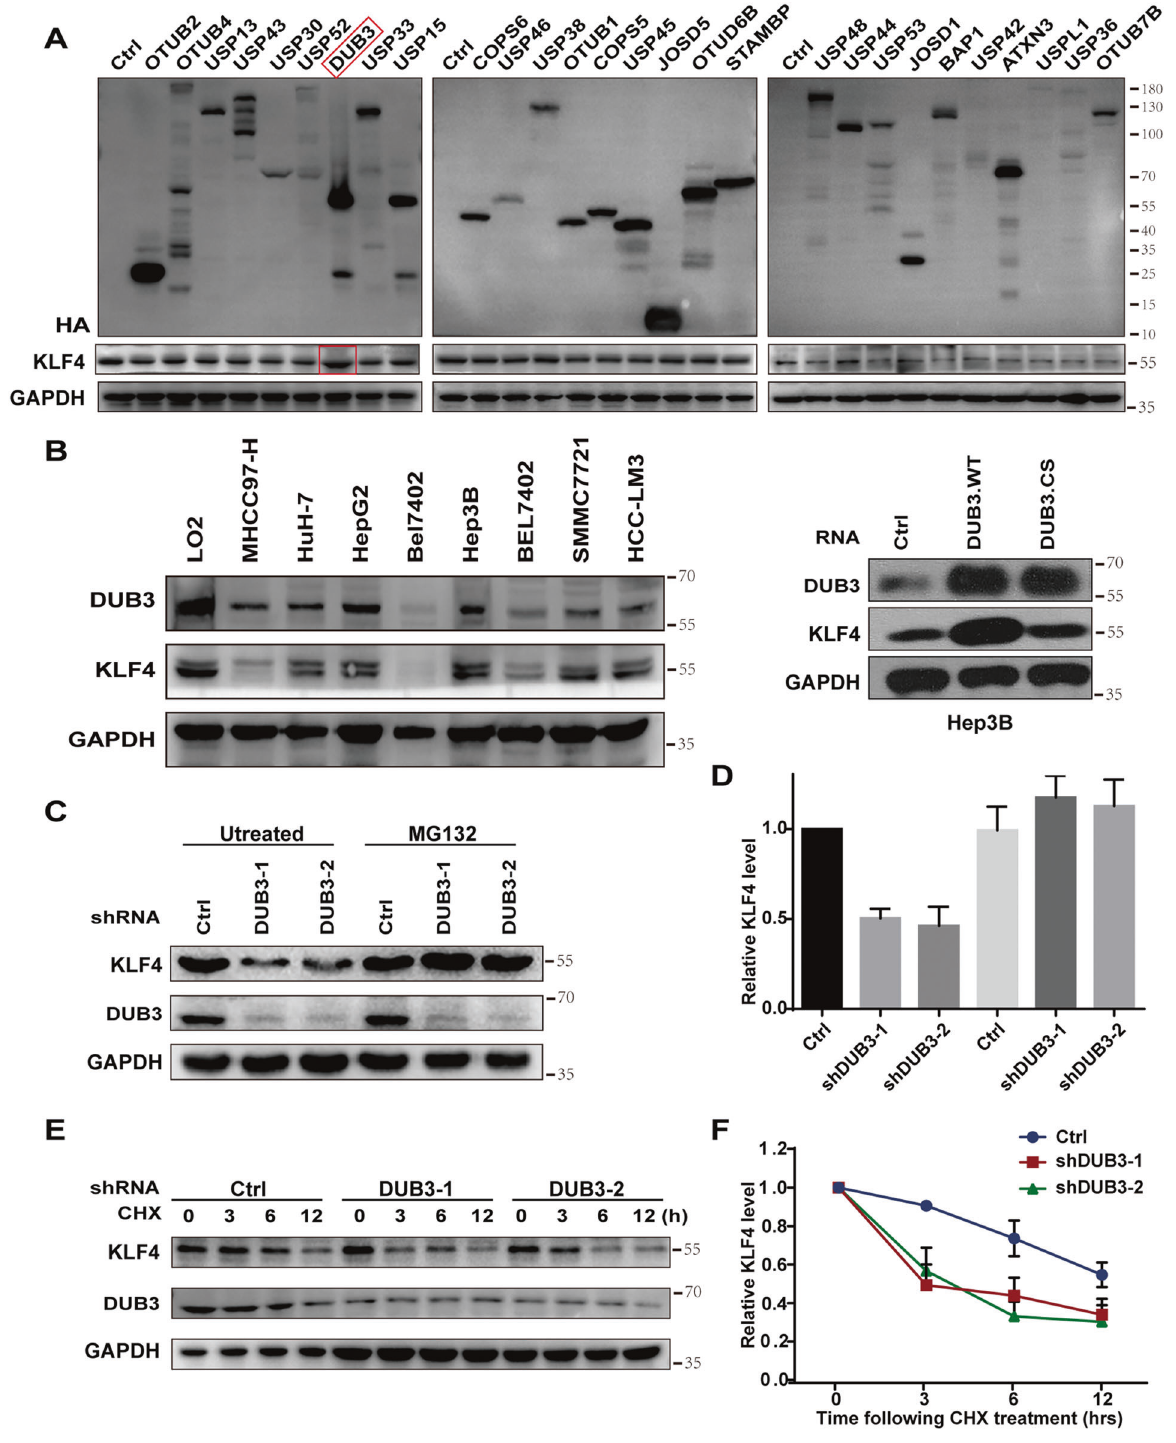
Fig. 1 Deubiquitinating enzyme 4 (DUB3) upregulated Krüppel-like factor 4 (KLF4) expression and stabilized KLF4 protein in hepatocellular carcinoma (HCC) cells. A HEK293T cells were transfected with deubiquitinase-overexpressing vectors (HA-tag) as indicated. Western blot analysis was performed to detect the protein expression of KLF4. B Left panel: The cell lysates from HCC cell lines were blotted for DUB3 and KLF4 expression. The cell lysates from normal liver (LO2) cells were used as a control. Right panel: Hep3B cells were transfected with wild-type DUB3- and C89S mutant-overexpressing vectors. The cell lysates were collected and blotted for DUB3 and KLF4 expression. GAPDH was used as an internal reference. C , D Hep3B cells stably expressing control (ctrl) or DUB3 shRNA (shDUB3) were incubated with vehicle or MG132 (25 μ M) for 5 h. Western blot analysis was conducted to determine the protein expression of KLF4 and DUB3. E , F Hep3B cells stably expressing ctrl shRNA or shDUB3 were treated with 0.1 mg/mL cycloheximide for 0, 3, 6, or 12 h. Western blot analysis was conducted to determine the protein expression of KLF4 and DUB3. Data are expressed as the mean ± standard error of the mean (SEM). * P < 0.05, ** P < 0.01, *** P < 0.001, vs. Ctrl; n = 3.